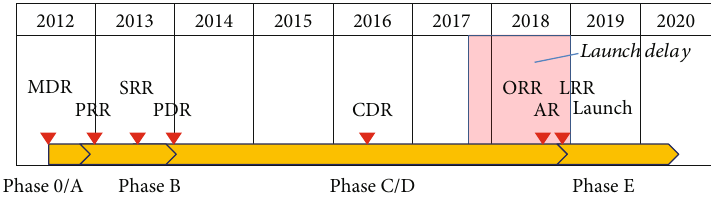
Figure 3: Project